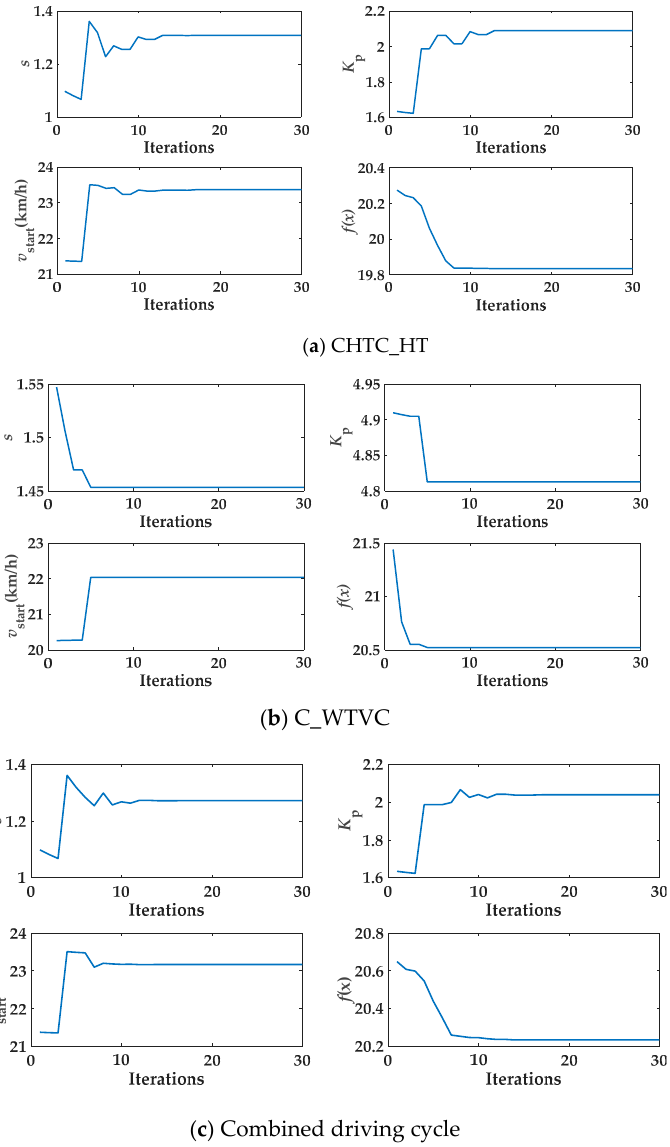
Figure 15. The parameter optimization results of ECMS under various driving cycles.